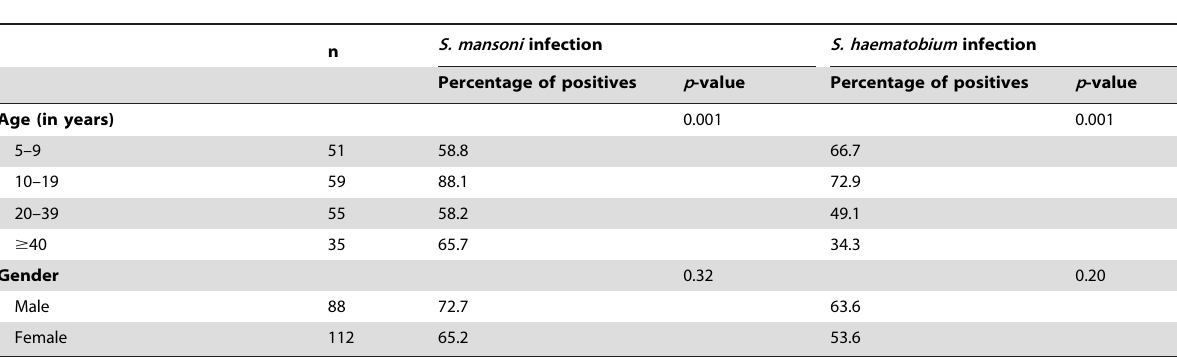
Table 2. Distribution of Schistosoma infection in the study